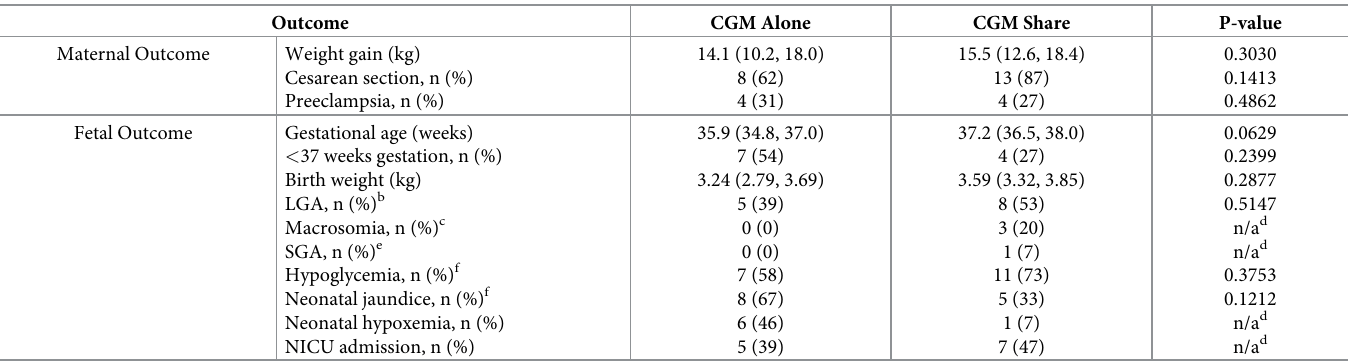
Table 3. Maternal and fetal outcomes a